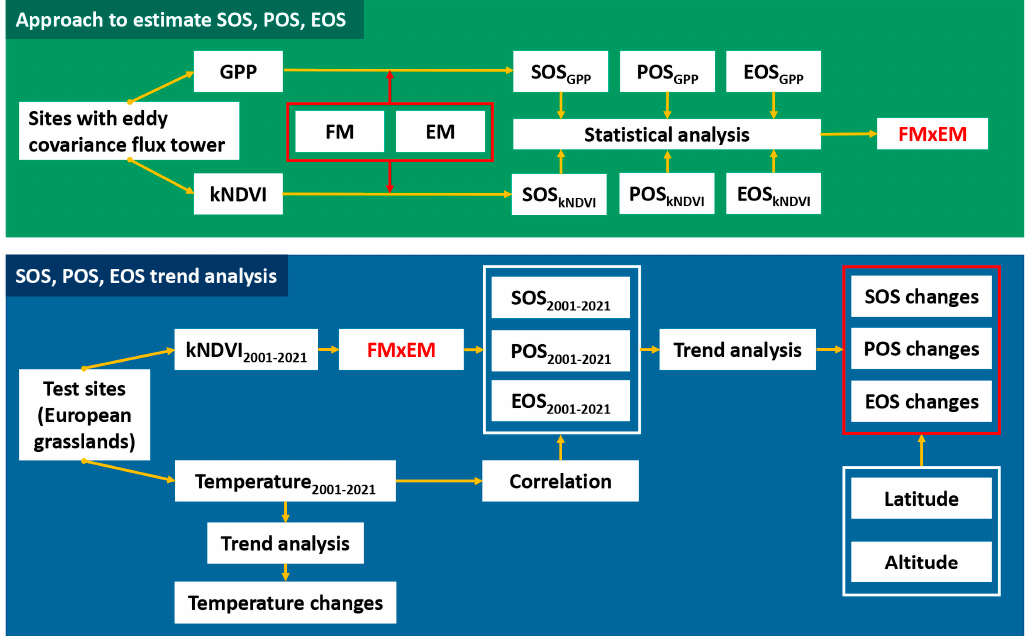
Figure 1. Workflow of the methodology, divided into “Approach to estimate SOS, POS, EOS” (2.1) and “SOS, POS, EOS trend analysis” (2.2).